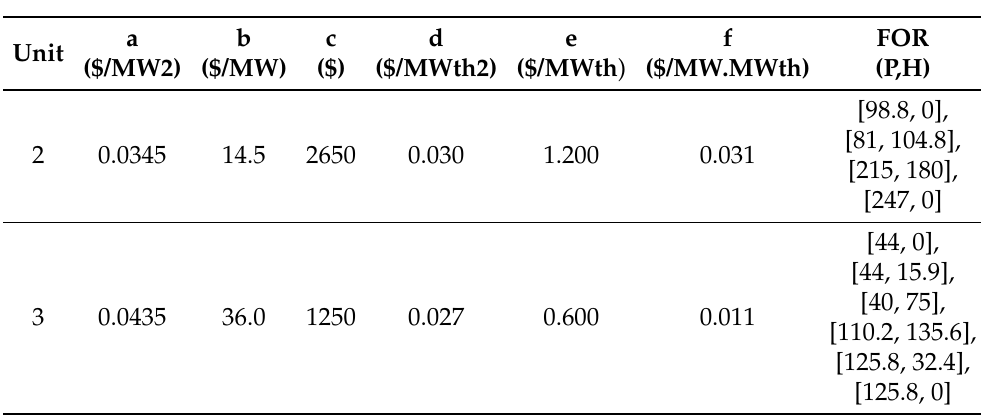
Table A2. Cogeneration unit data for Case Study 1